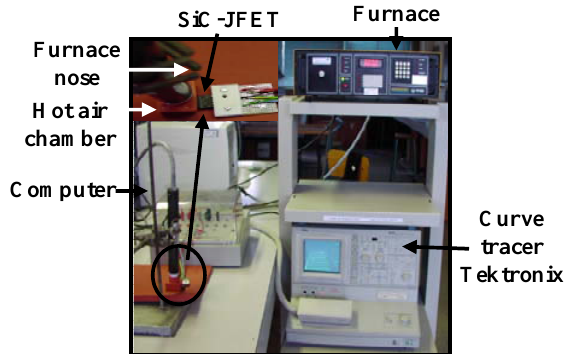
Figure 7. Experimental test bench for high temperature static characterisation of a